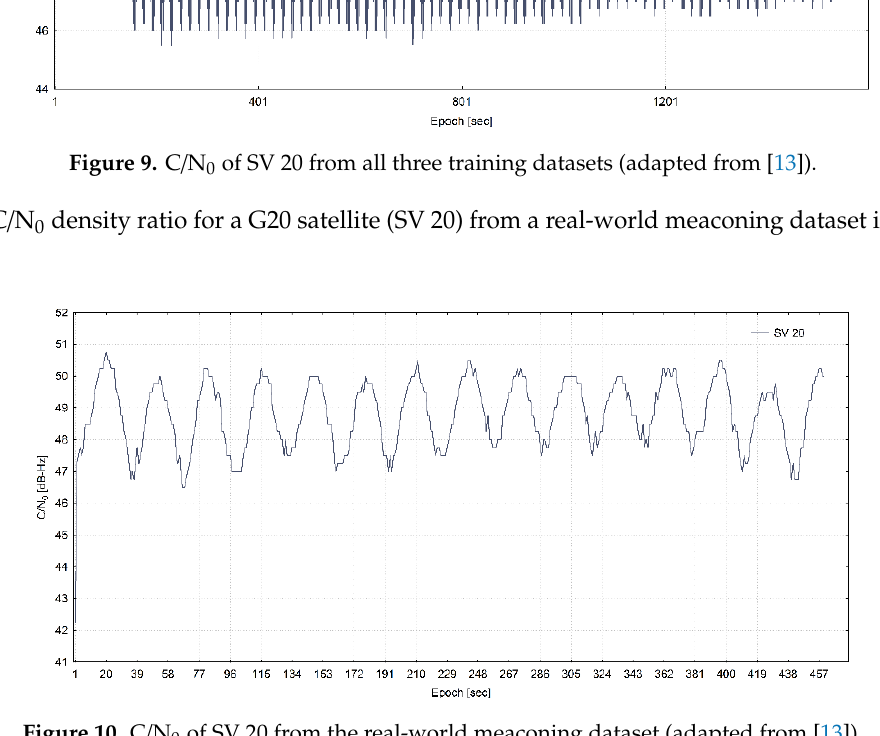
Figure 10. C/N 0 of SV 20 from the real-world meaconing dataset (adapted from [13]).